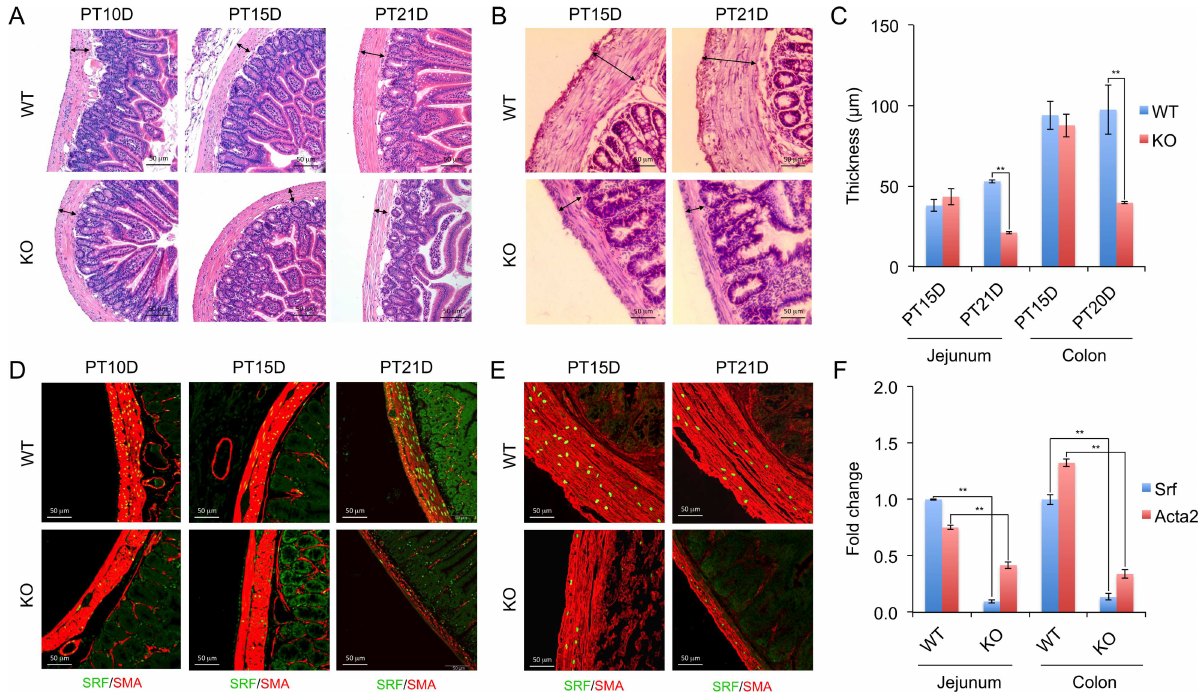
Fig 1. Smooth muscle degeneration in inducible SMC-specific Srf KO intestine. (A and B) Cross sectionalimages of WT and KO jejunum(A) and colon (B) with H&E staining 10, 15 and 21 days post-tamoxifen injection(PT10D, PT15D, and PT21D). Note that KO smooth muscle layers (arrows) are significantly thinner at PT15D and/or PT21D comparedto WT control. (C) Summary of thickness of smooth muscle layers in KO and WT. (D and E) Cryosection images of jejunum(D) and colon (E) stained with anti-SRF and anti-SMA antibodiesshowinggradualdepletion of SRF (green, nucleus)and reduction of SMA (ACTA2, red, cytoplasm) in KO SMC comparedto WT control at PT10D, PT15D, and PT21D. (F) qPCR analysisto validatereductionof Srf and Acta2 in KO jejunumand colon at PT15D. Ubb was used as an endogenouscontrol. Each data point (C and F) representsthe mean ± SD of experiments (n = 3). * p (cid:20) 0 . 05 and ** p (cid:20) 0 . 01 , WT versus KO.